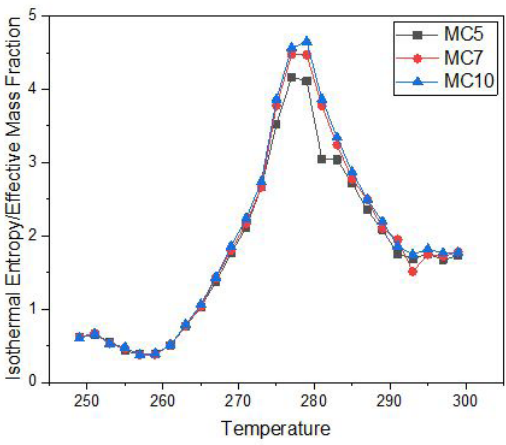
Figura 8. Effective PMMA mass fraction influence on the isothermal variation entropy [∆S /PMMA(g)] for various T